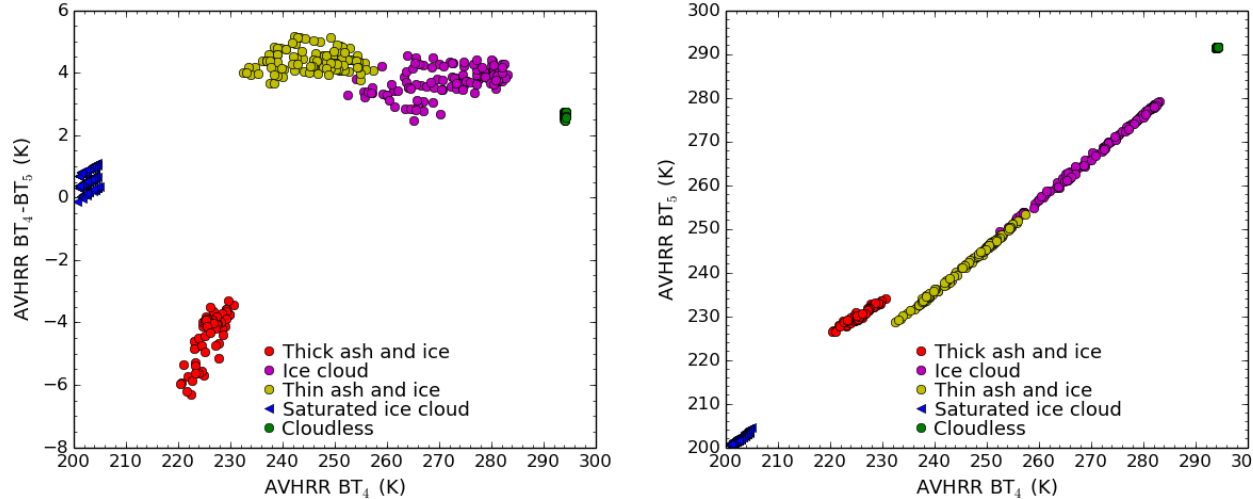
Figure 7. (Left panel) Measured AVHRR/3 BT 4 vs. BT 4 − BT 5 for the pixels marked in the right panels of Figs. 1 and 2 and listed in Table 1. (Right panel) Measured AVHRR/3 BT 4 vs. BT 5 for the same pixels as in left panel.